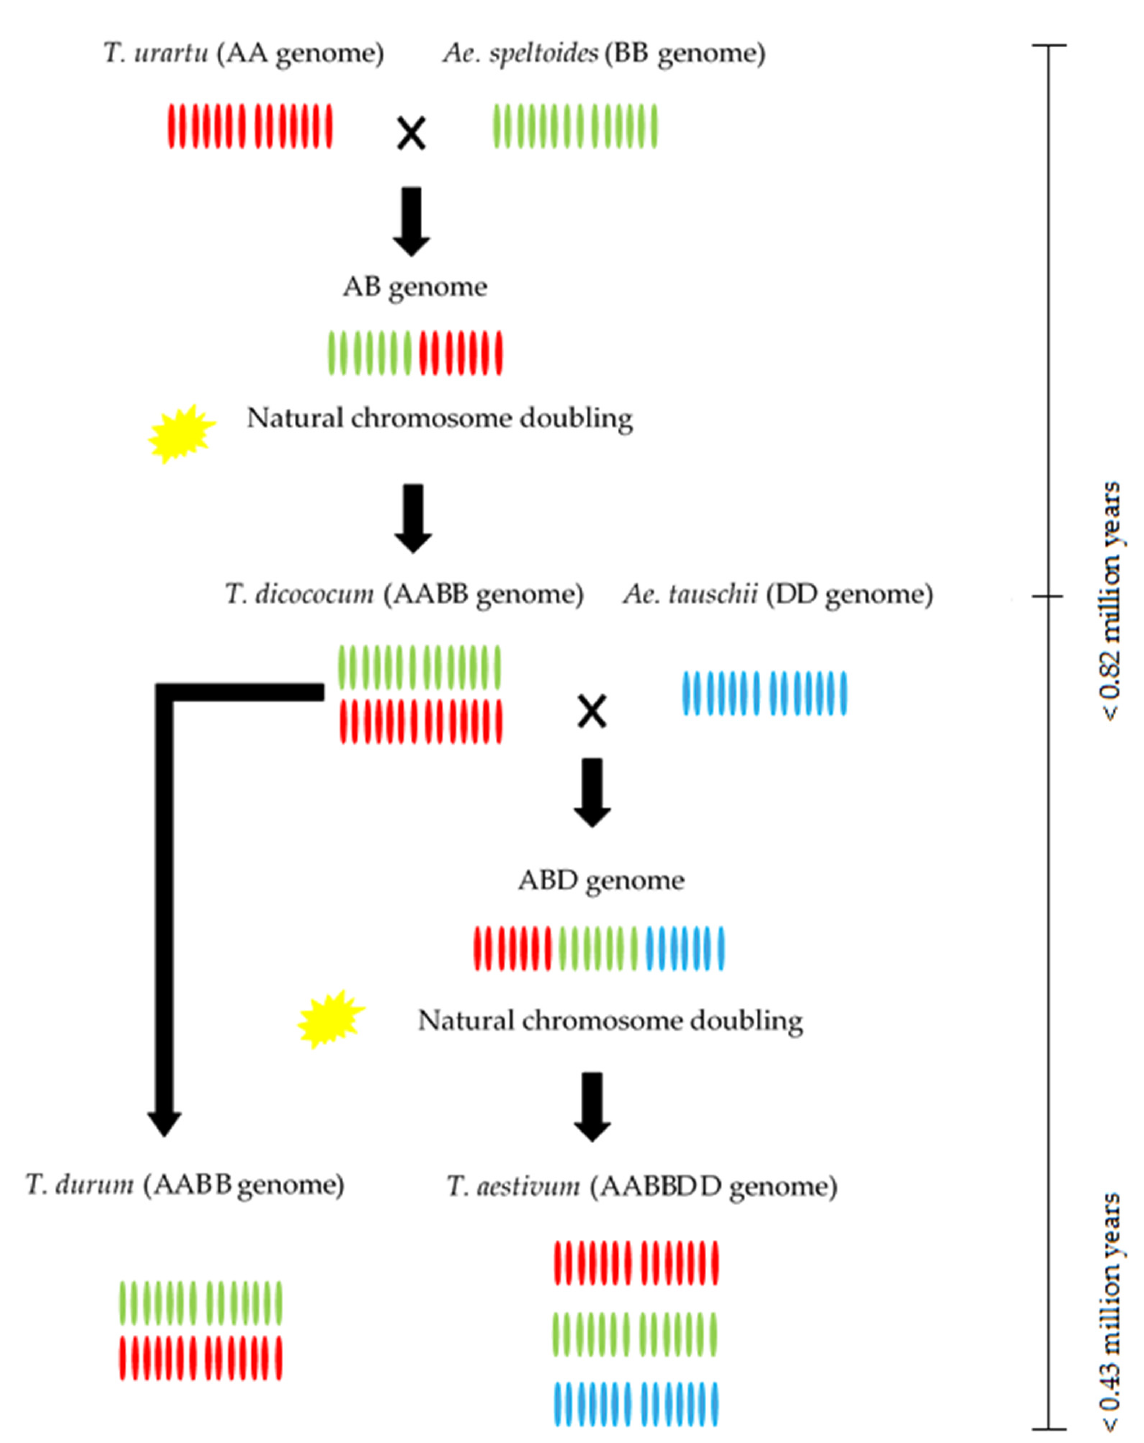
Figure 2. Information flow diagram for the domestication trend of wheat. Table 2. List of different Aegilops and Triticum species along with their genomic constitutions.